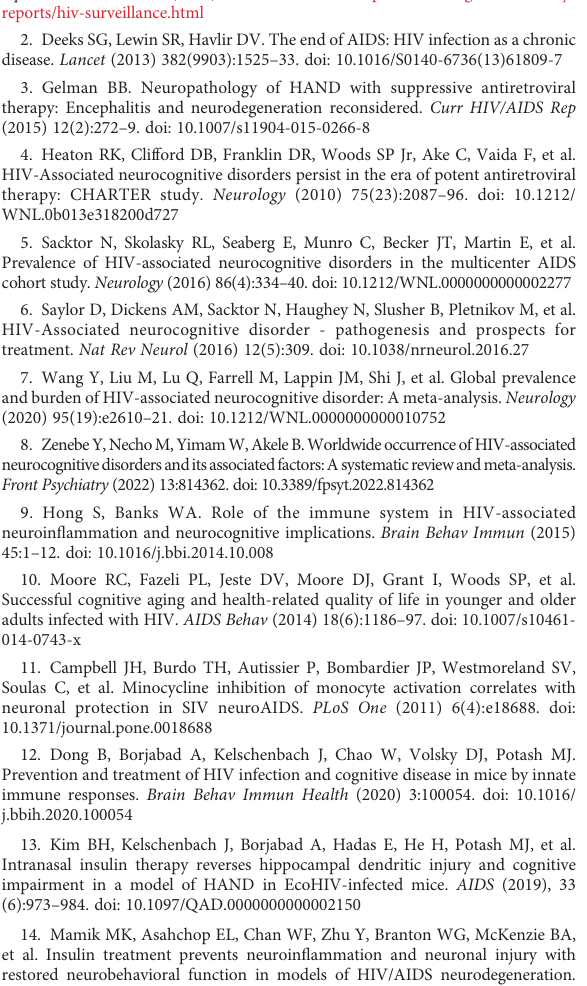
plots are representative images from an EcoHIV infected mouse used in our studies. The fi rst panel represents all cells obtained from cell suspension